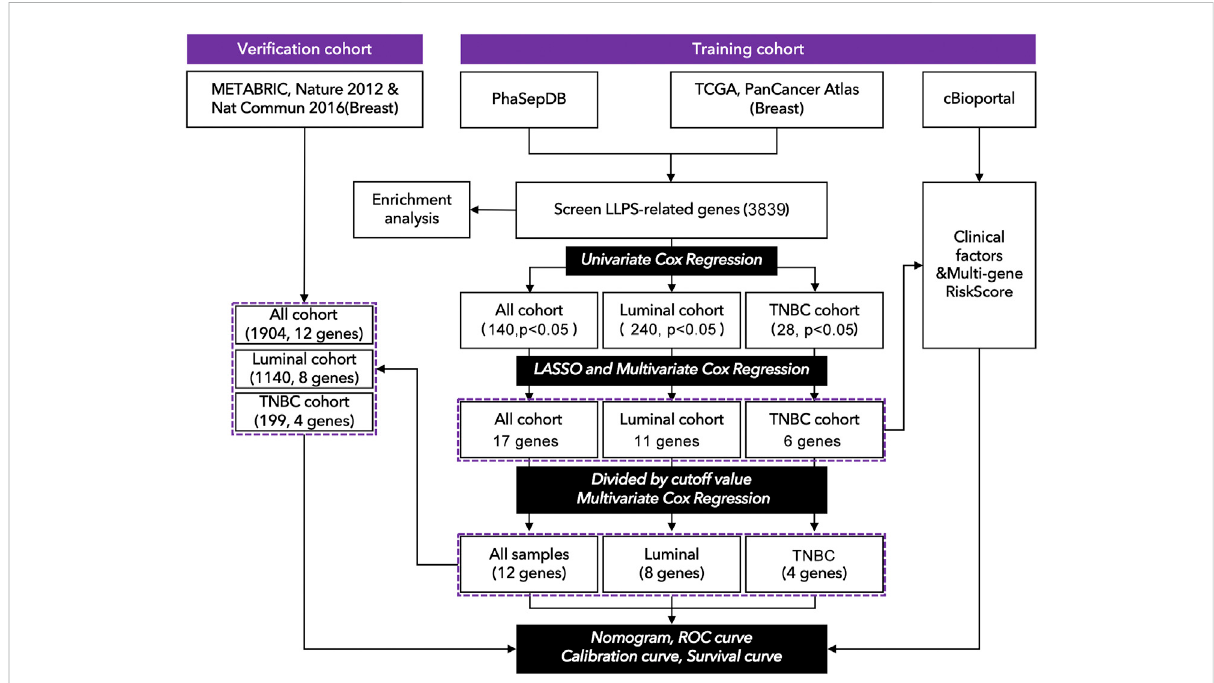
FIGURE 1 Technologyroadmapofstudy.(1)Geneexpressionpro fi leswerecollectedfromTCGA:https://portal.gdc.cancer.gov.(2)Clinicalcharacteristics were collected from cBioportal http://www.cbioportal.org. (3) The genomic list of LLPS-related genes was collected from PhaSepDB: http://db. phasep.pro. (4) Data analysis was performed in R4.0.1 and SPSS